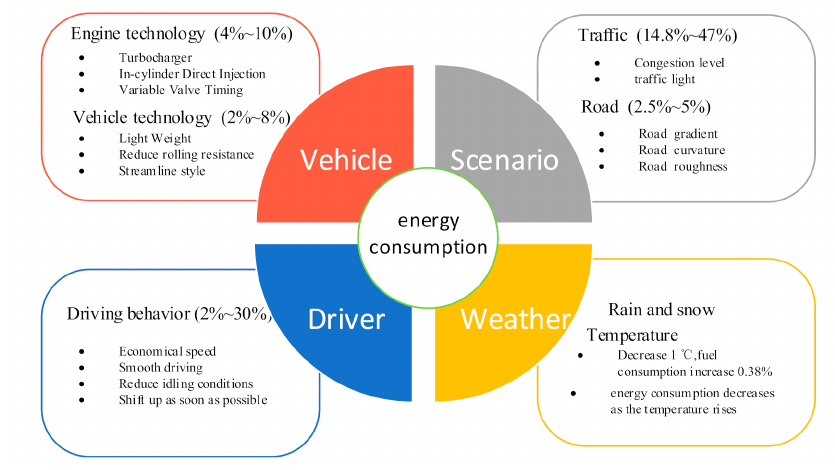
Figure 2. The primary factors affecting vehicle energy consumption.